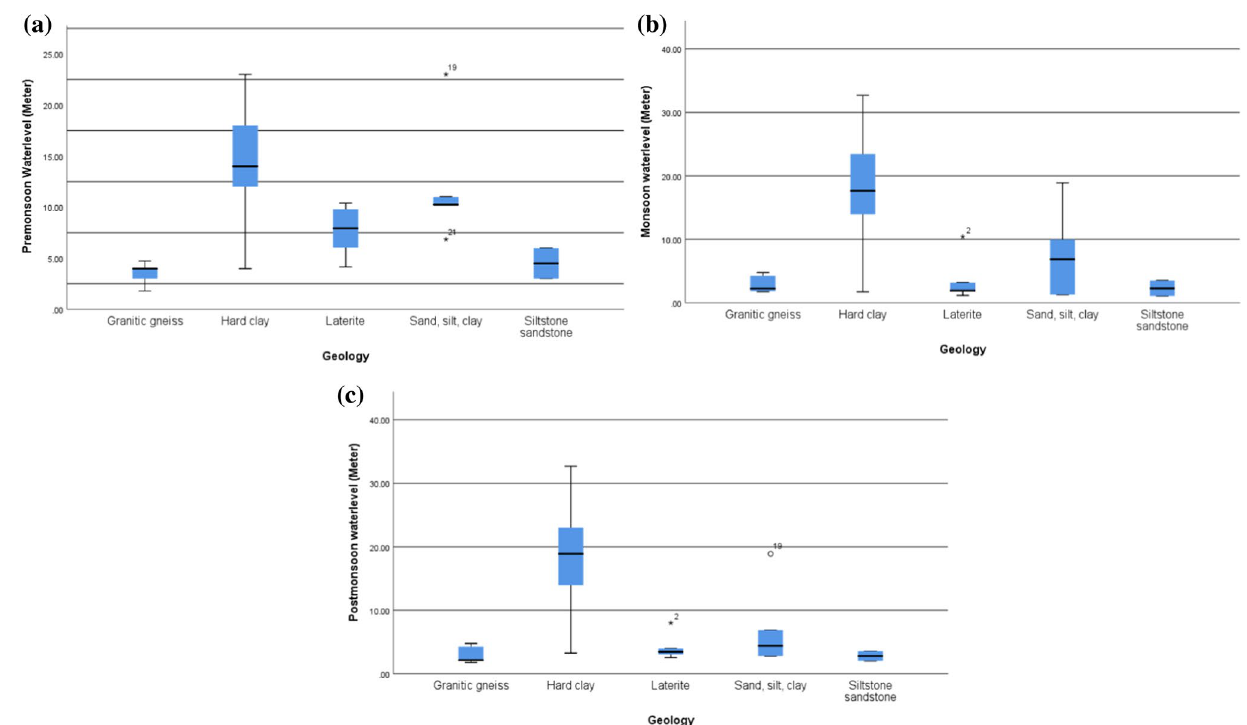
Fig. 12 Boxplots of groundwater level fluctuation in different geological facies during pre-monsoon, monsoon and